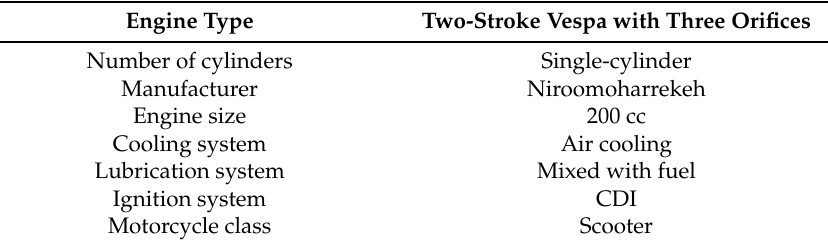
Table 2. The two-stroke engine’s technical specification.